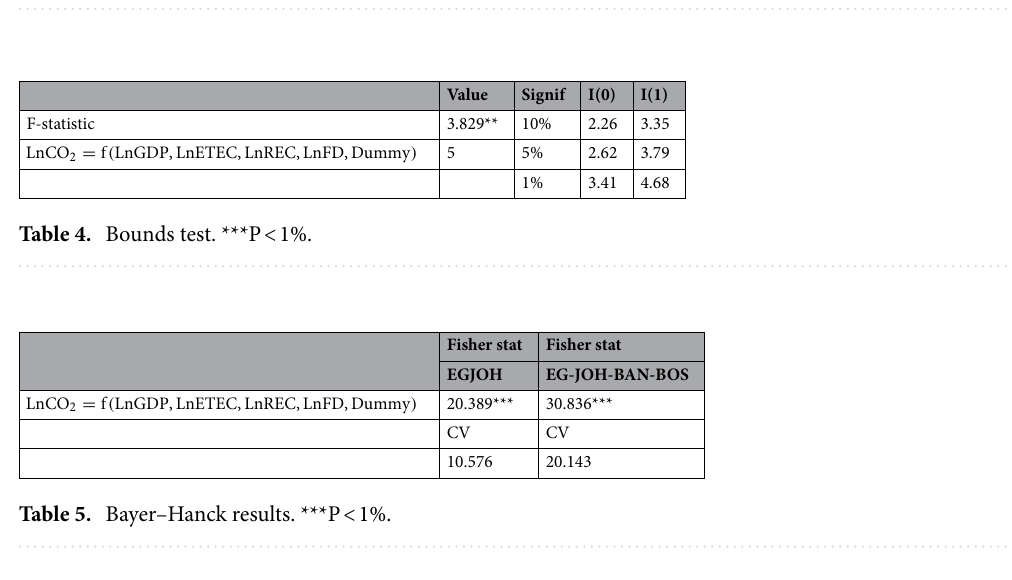
Table 3. Stationarity test results. ***P < 1%, **P < 5% and *P < 10%.